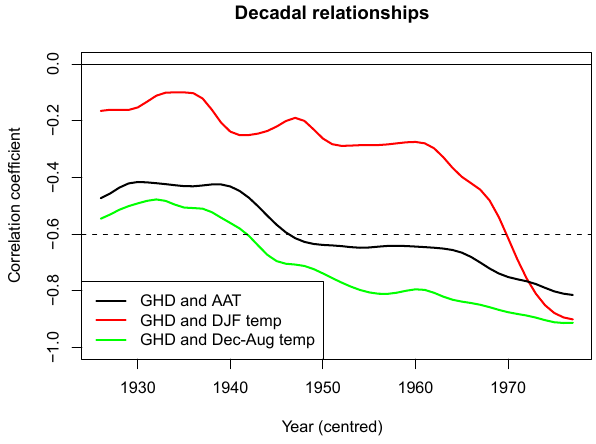
Fig. 8. Running correlation of the GHD with France AAT (black), DJF temperature (red), and December-to-August temper- ature (green). All data are low-pass filtered prior to the correlation (1/10 year cutoff). The length of the time window is 50 years. The horizontal dashed line shows the p =0.05 significance